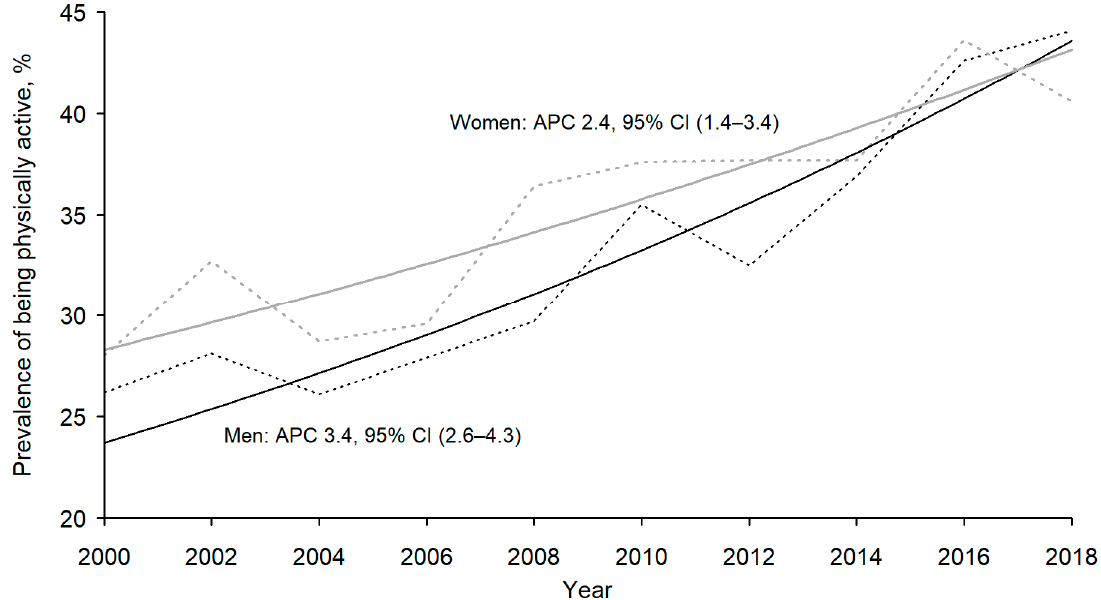
Figure 1. Trends in the prevalence of leisure time physical activity (LTPA) and respective annual percentage change (APC) by gender in Estonia 2000–2018. Dashed line marks the observed prevalence of LTPA, continuous line refers to annual percentage change for trend among men and women. Table 3. Association between LTPA (yes vs. no) and explanatory factors, 2000–2018, OR with 95% CI a . Variables